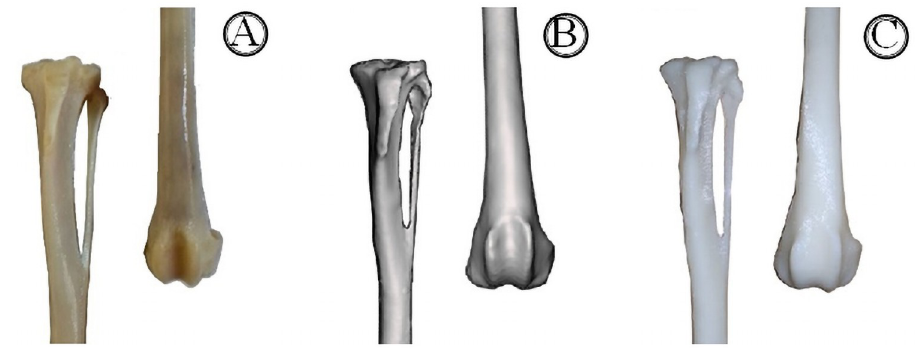
Fig 1. Healthy bones after maceration (A), edition (B) and printing (C), respectively. Focus on the proximal border of the tibia and the distal part of femur.